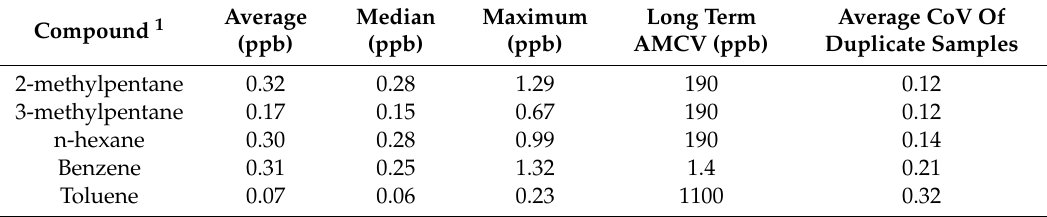
Table 1. The volume mixing ratio statistics of hydrocarbons measured in this study compared to air monitoring comparison values (AMCV) provided by the Texas Commission on Environmental Quality (TCEQ) [36]. Compound 1